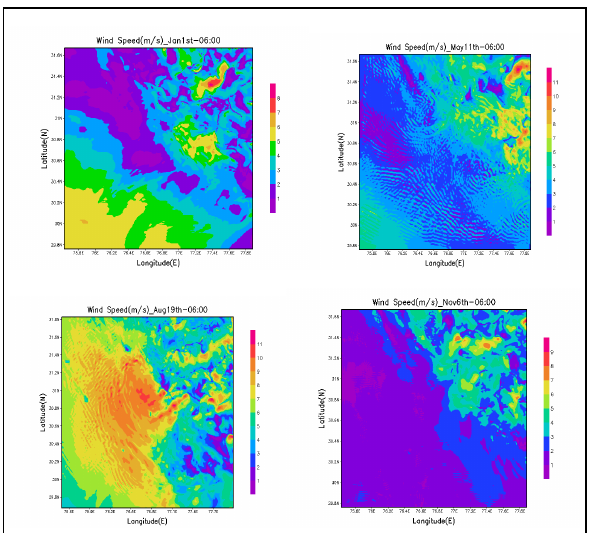
Figure 5. Spatial distribution of Wind speed over d02 on 1st 11th different seasons Jan 11:30 IST, May 11:30 IST, Aug 19th 6th 11:30 IST and Nov 11:30 IST with BEP+BEM Urban Physics